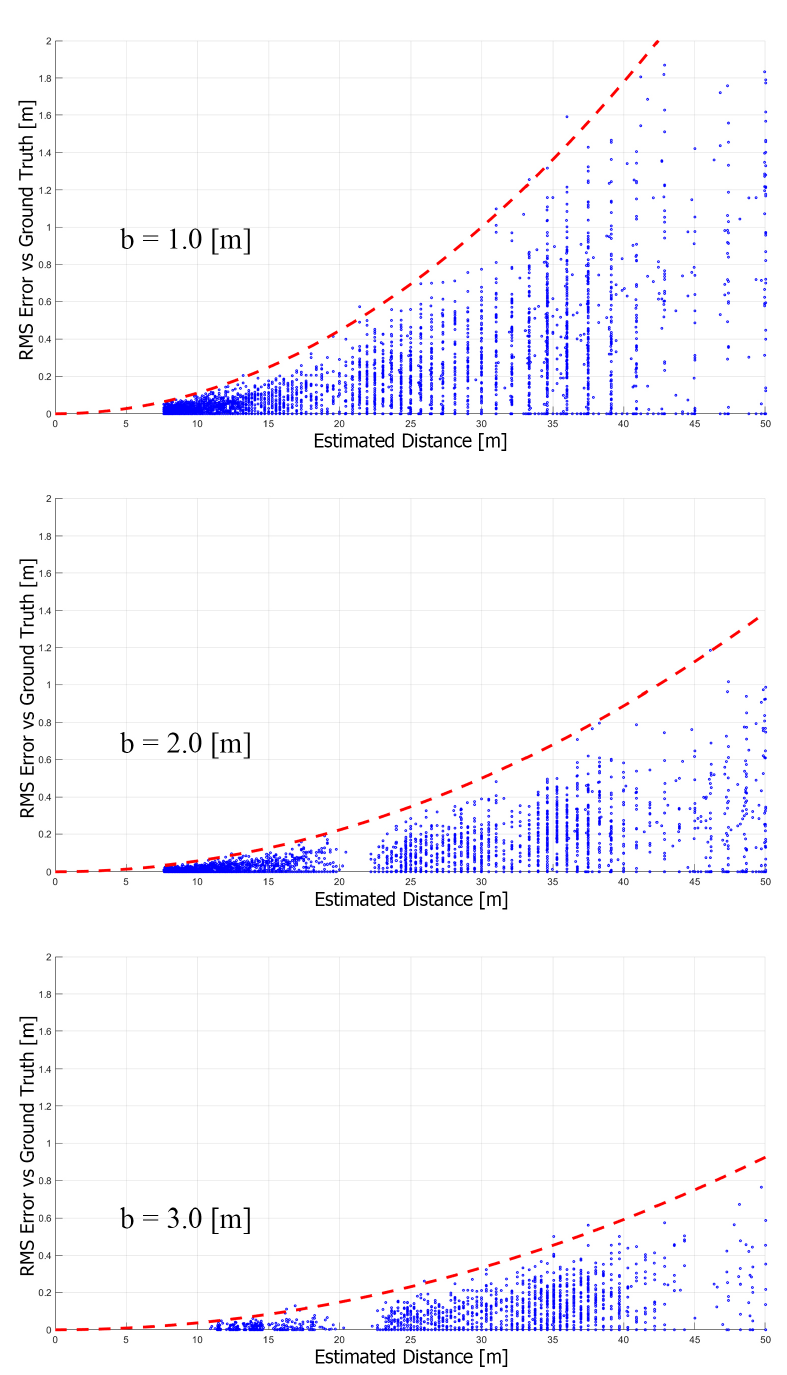
Figure 15. Error of estimated depth of area of interest (a) compared to ground truth in 1/100 density. The x-axis is the estimated depth, the y-axis is the estimation error, and the red dashed line is the estimated error given by the theoretical